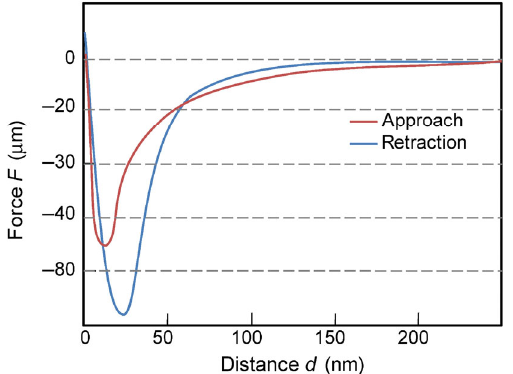
Fig. 6 An example of experimental force-distance curves measured by means of CAM (adopted from Ref.